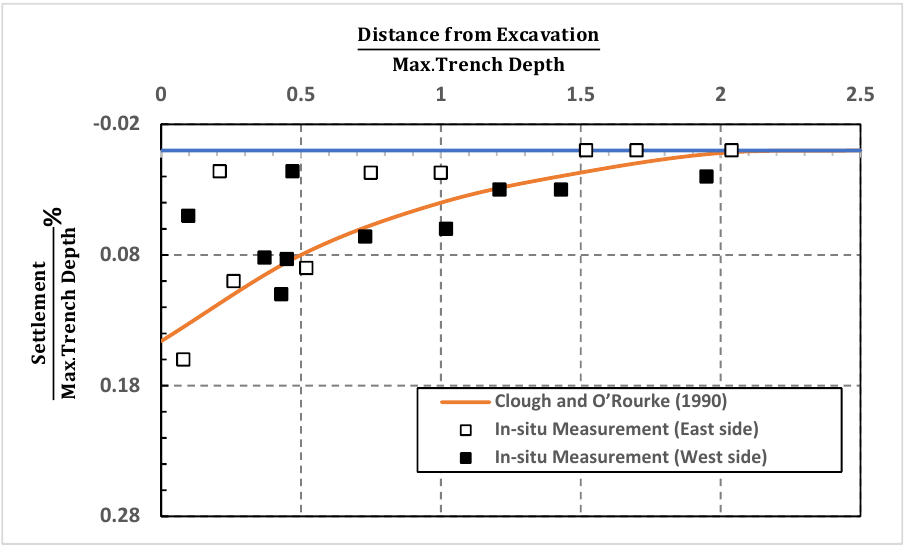
Figure 14. Allocation of the in-situ measured soil vertical settlement corresponding to the horizontal distance from the excavation zone on the Clough and O’Rourke, chart [14].